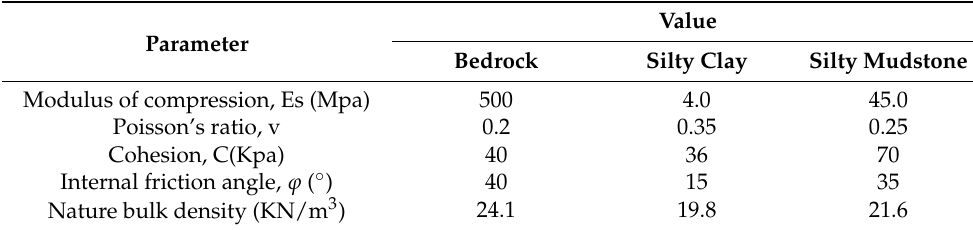
Table 3. Physical parameters of each layer.